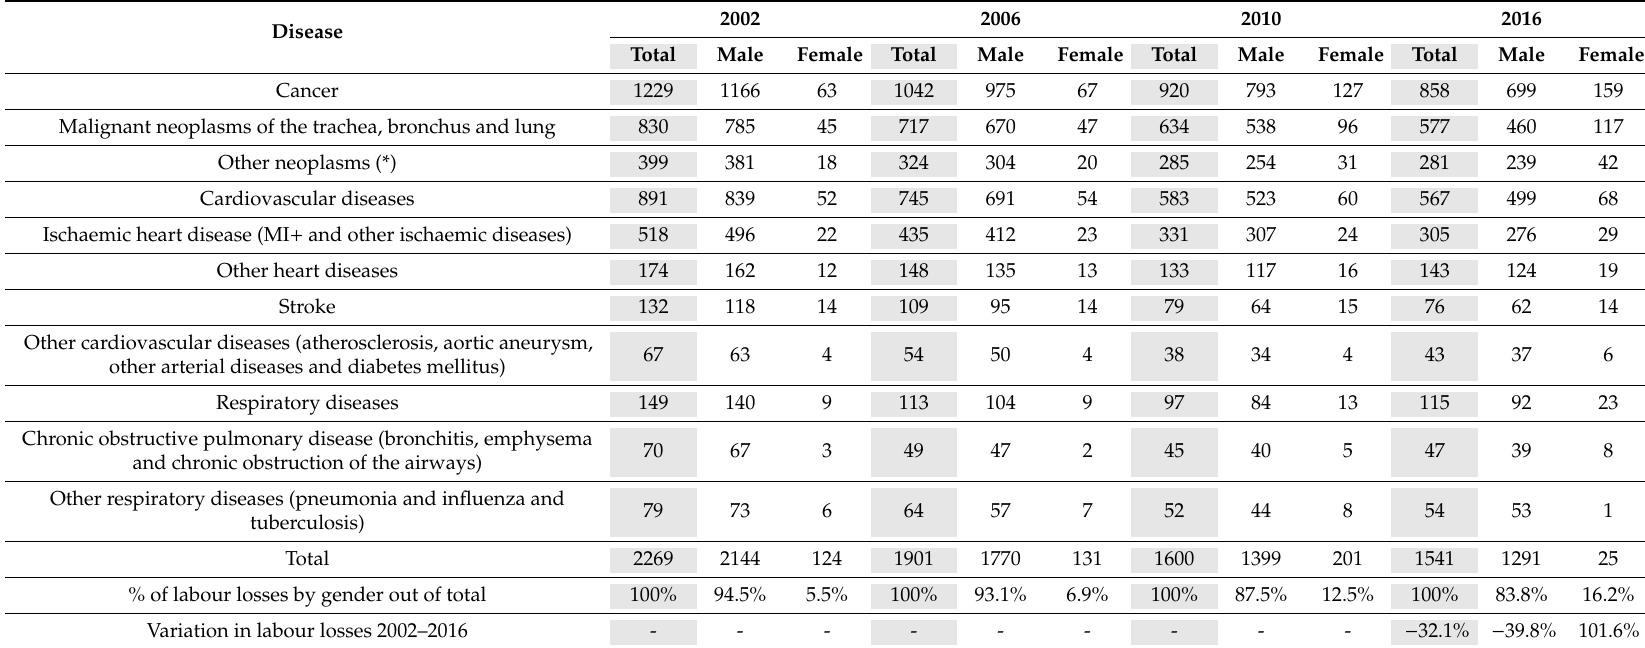
Table 3. Labour losses (constant millions of 2016 euros) in working age population (35 to 64 years).